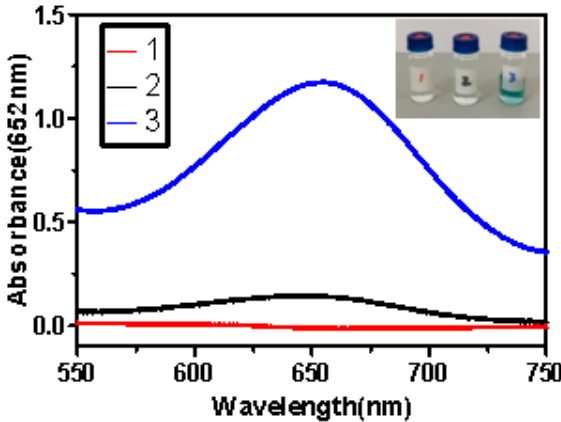
Figure 1. UV absorption of ( 1 ) Dh–A–H–E + 3,3’,5,5’–tetramethylbenzidine (TMB), ( 2 ) TMB + H 2 O 2 , and ( 3 ) Dh–A–H–E + TMB + H 2 O 2